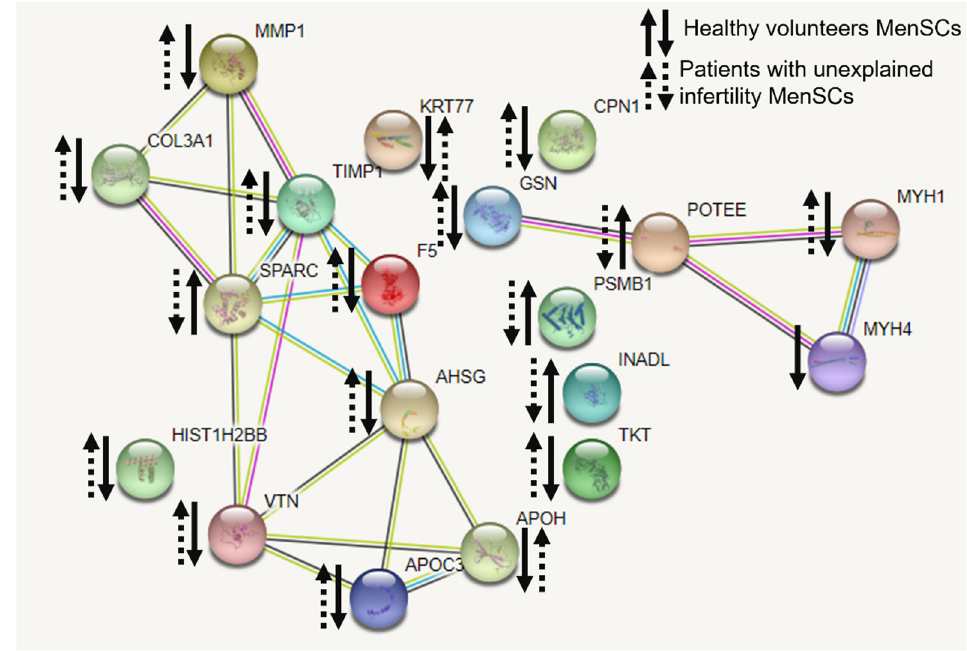
Figure 8. Interaction networks of secreted proteins from menstrual stem cells of healthy volunteers and patients with unexplained infertility during decidualization. The ↑↓ symbols—upregulation or downregulation of proteins in the samples. The interaction networks of secreted proteins and their involvement in different biological processes were identified using the STRING database (https://string-db.org/cgi/network?taskId=bQ56qZB0Kkow&sessionId=bcvMfLgxWFKc, retrieved 20 January 2021).